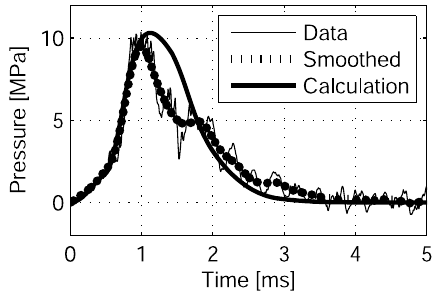
Fig. 12. Example of calculated versus recorded pressure.